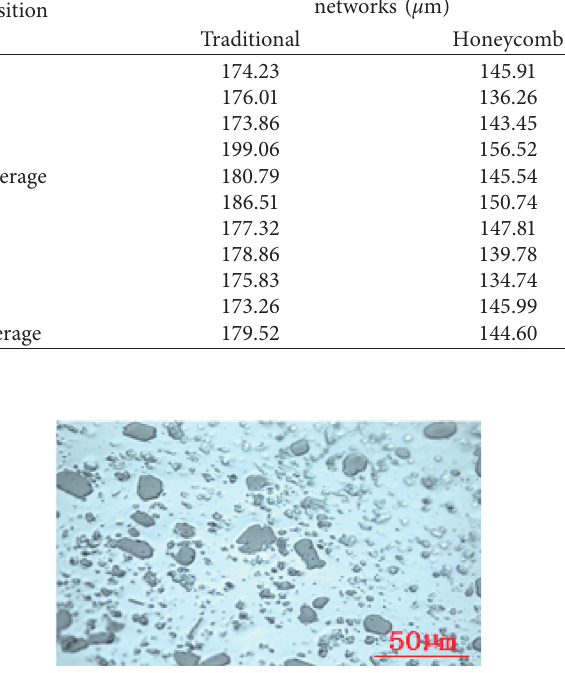
Figure 18: Metallography of honeycomb